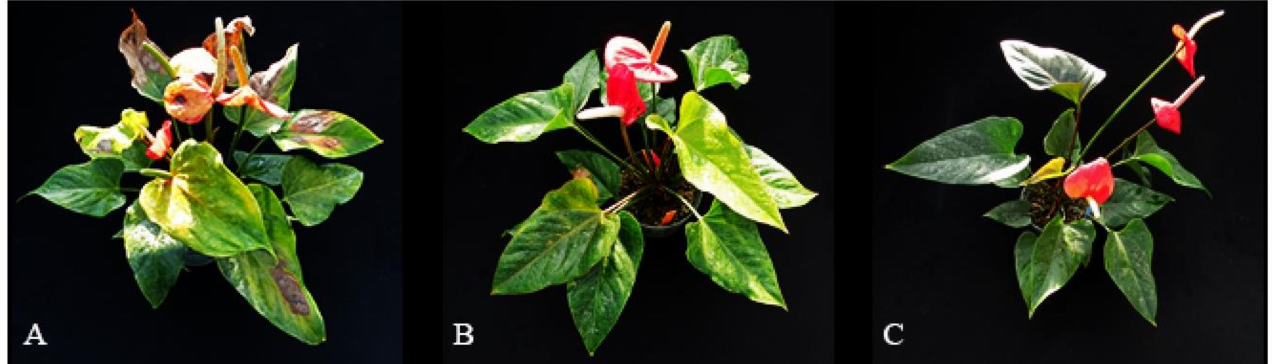
Figure 6. The appearances of Anthurium × ‘Red’ grown in a shaded greenhouse under H ( A ), M ( B ), and L ( C ) light levels (550, 350, and 255 µ mol · m − 2 · s − 1 ,